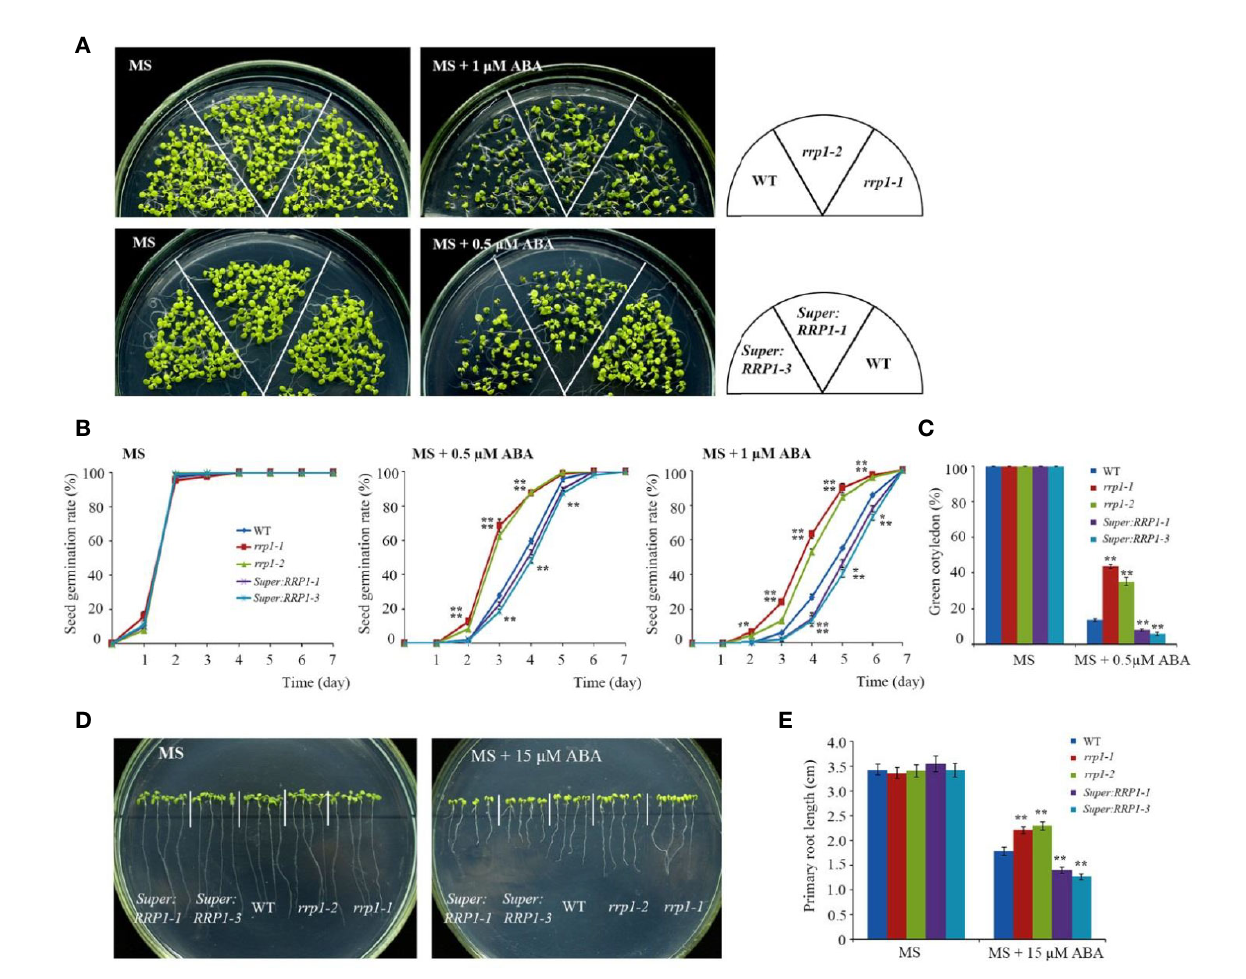
FIGURE 2 | ABA sensitivity in the rrp1 mutants and the RRP1 -overexpression Arabidopsis lines. (A) Phenotypic comparison analysis. Imbibed seeds were transferred to Murashige and Skoog (MS), MS + 0.5 m M ABA, and MS + 1 m M ABA medium and grown for 14 days. (B) Seed germination assay. Imbibed seeds were transferred to MS and MS medium supplemented with 0.5 or 1 m M ABA. Seed germination frequency was calculated at a given time. Data are the mean ± SE ( n = 3). More than 300 seeds were measured in each replicate. (C) Cotyledon-greening analysis. Imbibed seeds were transferred to MS or MS + 0.5 m M ABA medium for 6 days before determination of cotyledon-greening percentage. Data are the mean ± SE ( n = 3). More than 300 seeds were measured in each replicate. (D, E) Primary root length in the presence or absence of exogenous ABA. The 3-day-old seedlings were transferred to MS or MS + 15 m M ABA medium for 7 days, and then photographs were taken and the primary root length was measured. Asterisks in (B, C, E) indicate statistically signi fi cant differences compared with wild- type plants: *, P < 0.05; **, P <